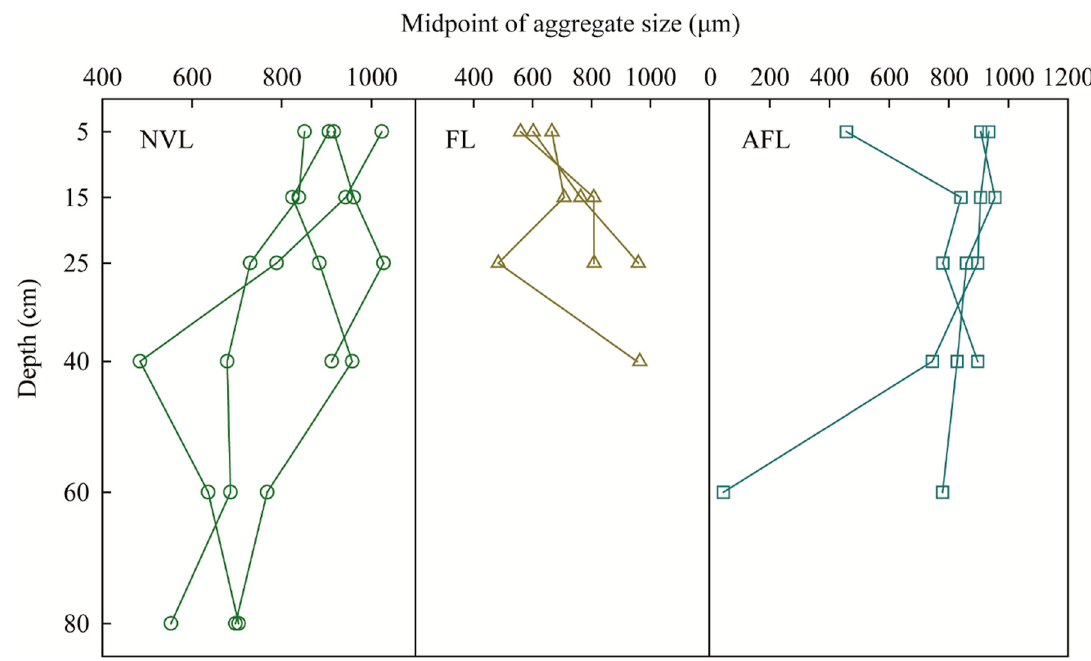
Figure 4. The soil aggregate size distributes with depth under native vegetation land (NVL), farmland (FL), and abandoned farmland (AFL).